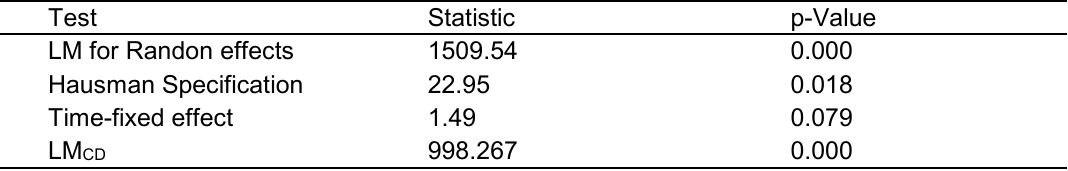
Table 2. Summary of preliminary tests